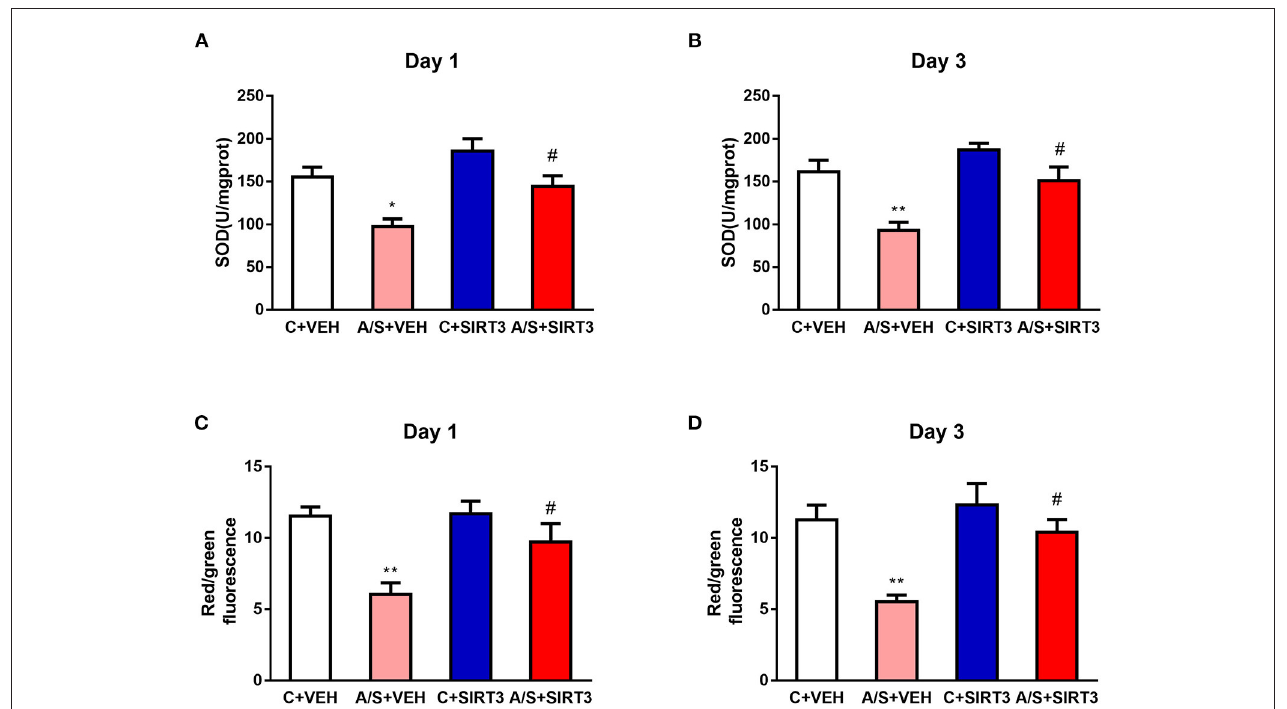
FIGURE 3 | Effect of SIRT3 overexpression on mitochondrial oxidative levels. (A–D) Analysis of SOD2 and MMP in the mPFC region among the four groups ( n = 6 per group, * p < 0.05; ** p < 0.01; # p < 0.05). Data are presented as the means ±